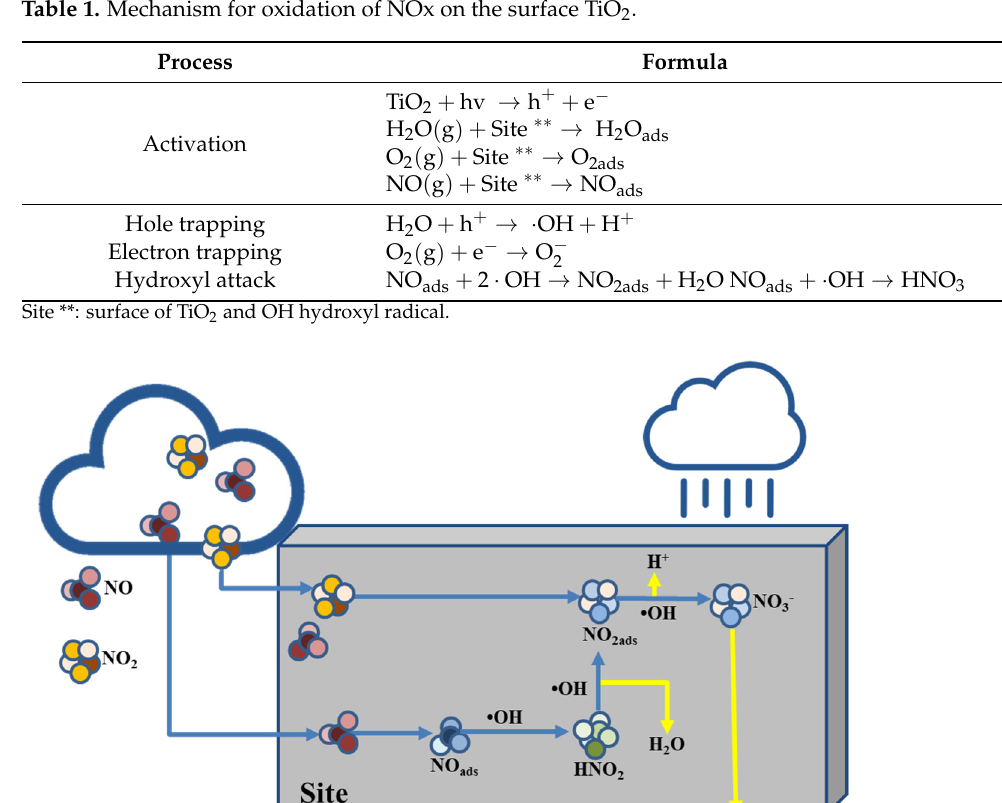
Table 1. Mechanism for oxidation of NOx on the surface TiO 2 .